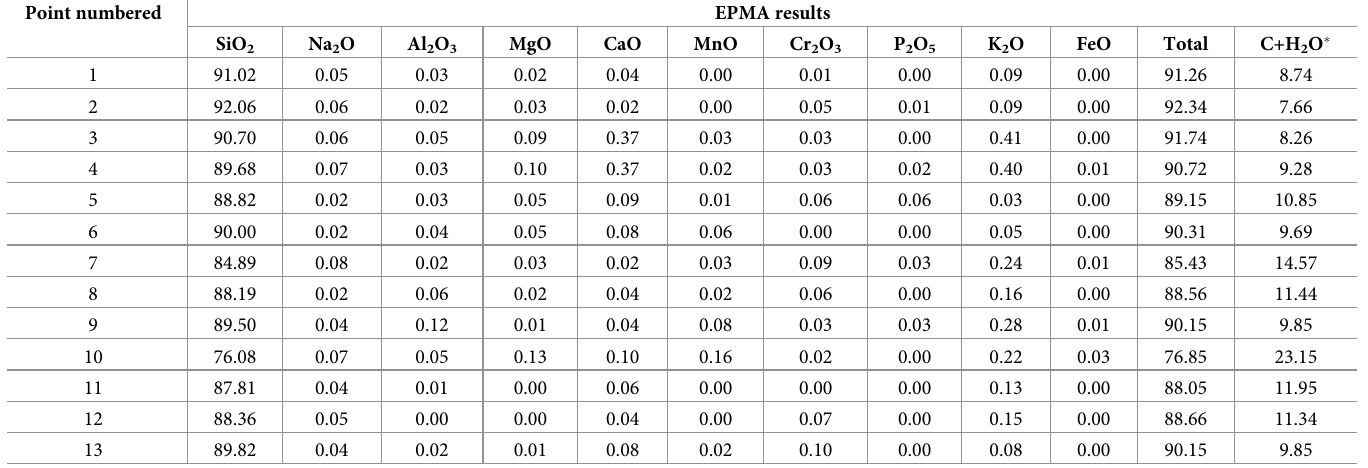
Table 2. The EPMA results of each numbered micro-area of major phytolith morphotypes (unit: